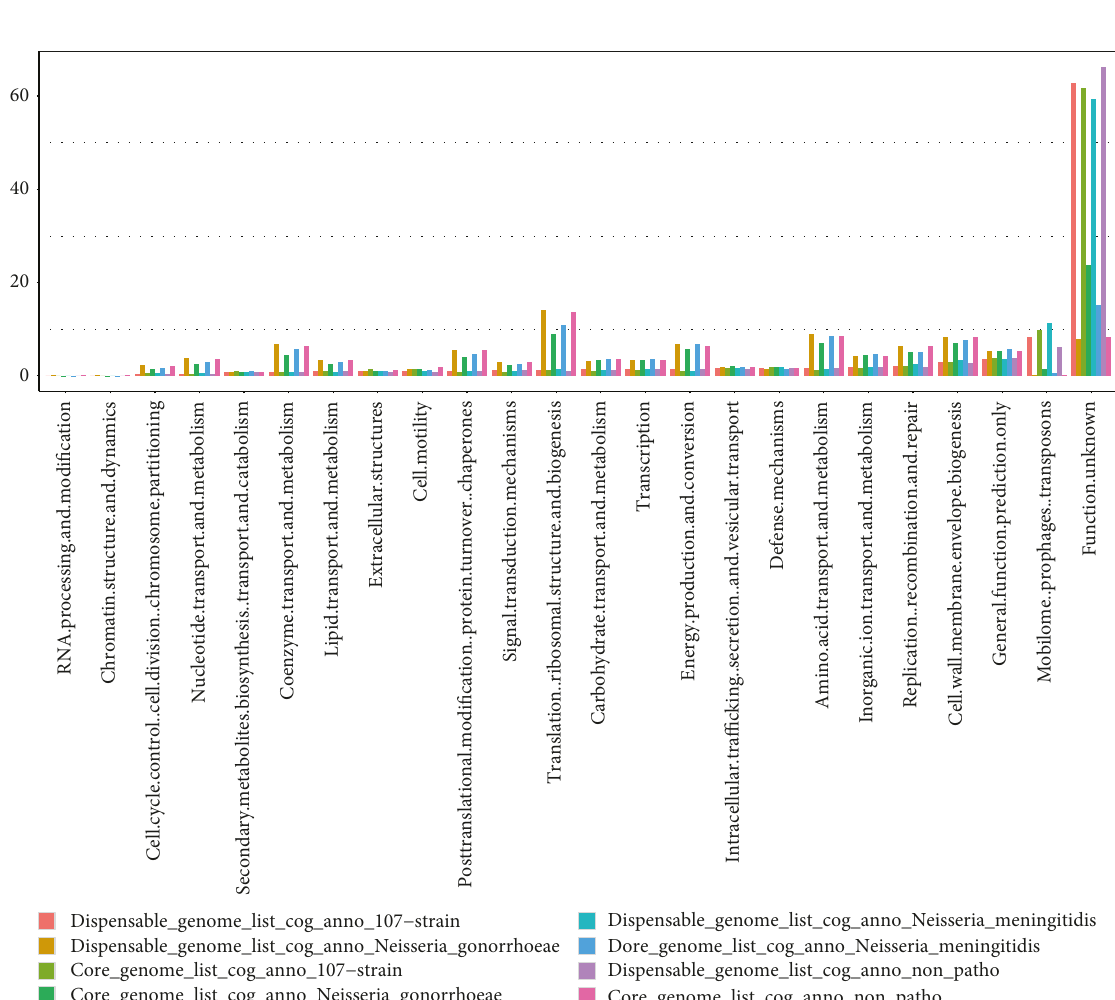
Figure 4: Functional category of core and accessory genome components by COG database. Core and accessory genomes of ATNS, NMS, NGS, and NPNS were showed with di ff erent colors, respectively. The genes unassigned to any COG categories were combined into category “ function unknown.